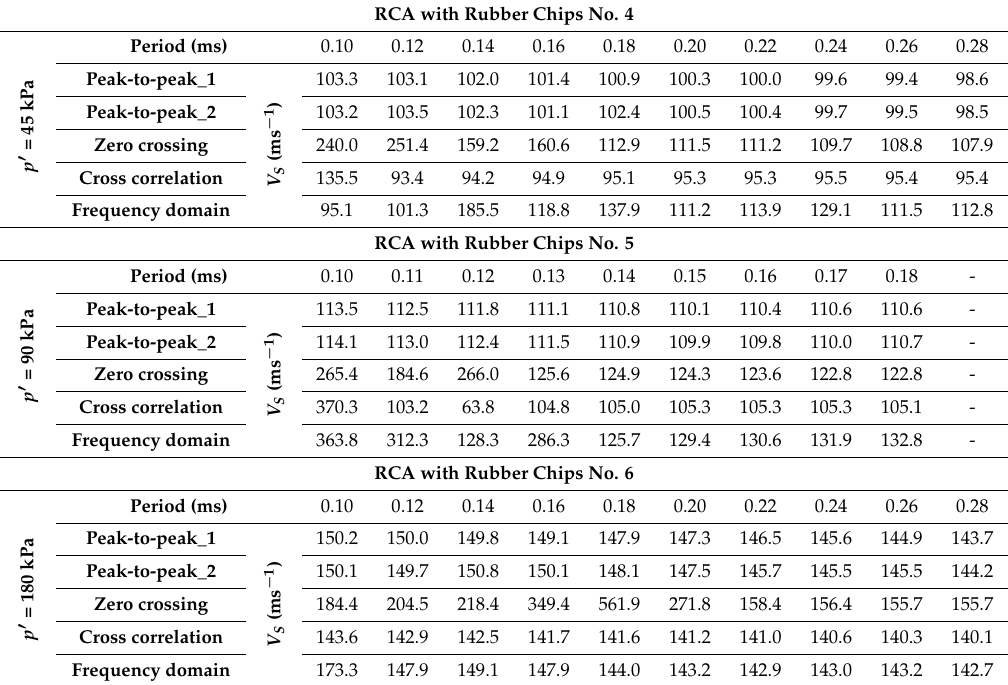
Table 4. Shear wave velocity ( V S ) of mixtures of RCA with rubber chips by four different methods of interpretation and three different mean effective